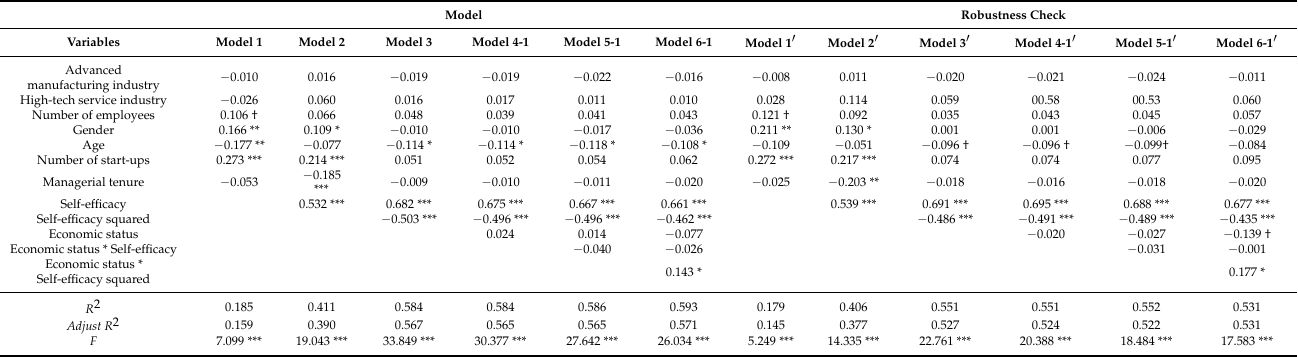
Table 4. Results of sensitivity